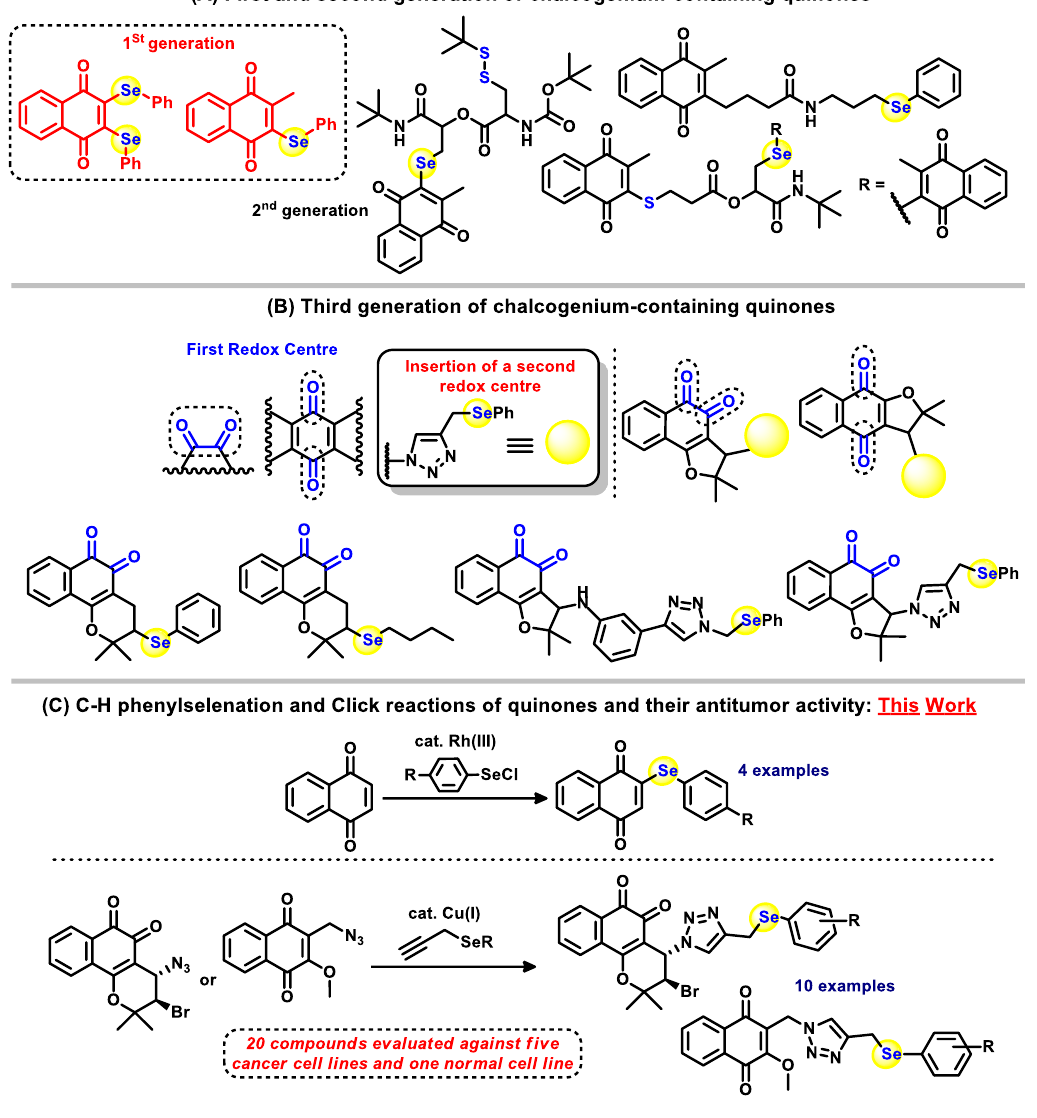
Scheme 1. Overview of the different generations of hybrid redox molecules for the first and second generation (Panel ( A )) to the third generation with lapachones (Panel ( B )) and the products of Rh- activated C-H bond activation and click reactions (Panel ( C )).